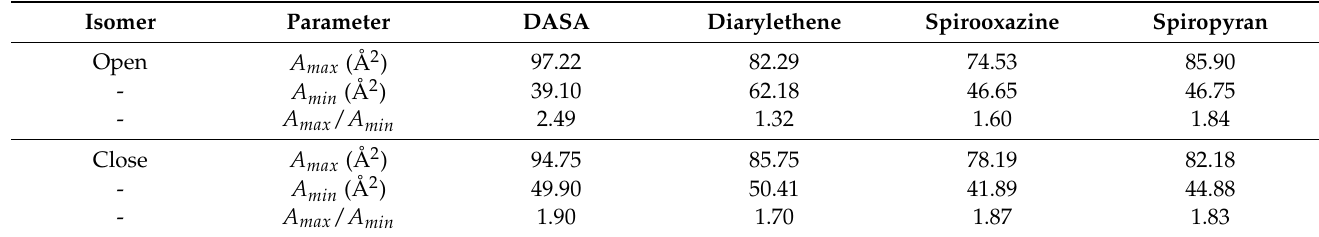
Table 2. Characteristics of O/C optical switches in open and closed